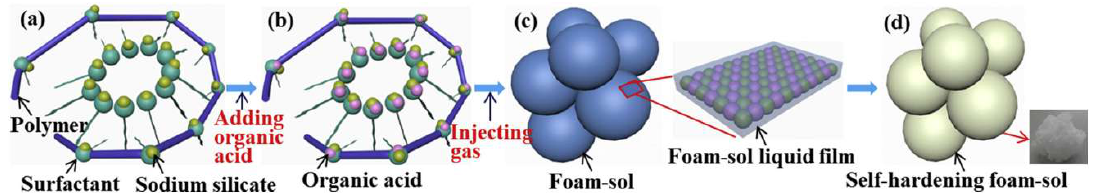
Figure 9. The detailed structural scheme of special conic nozzle used for spraying foam sol [41].